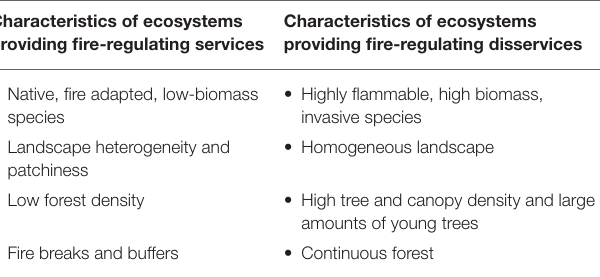
TABLE 1 | Characteristics of the (managed) ecosystem that lead to fire-regulating services and disservices. Characteristics of ecosystems Characteristics of ecosystems providing fire-regulating services providing fire-regulating